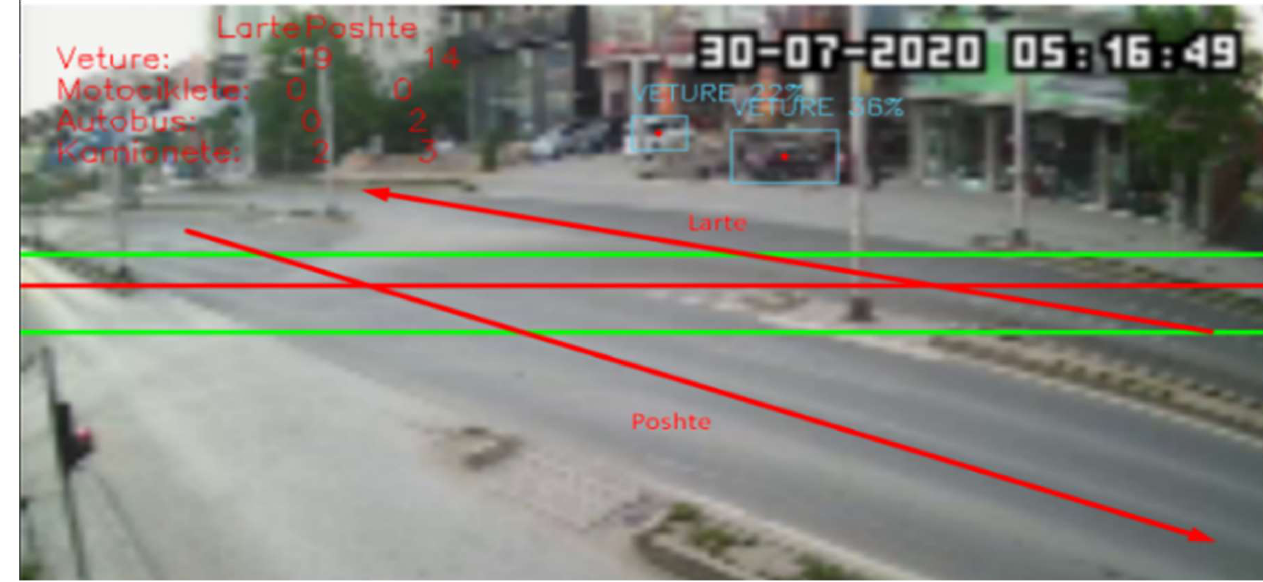
Figure 4. Traffic count from camera and data processing in program (05:00–05:15). Table 1. Results obtained from camera count in the morning.